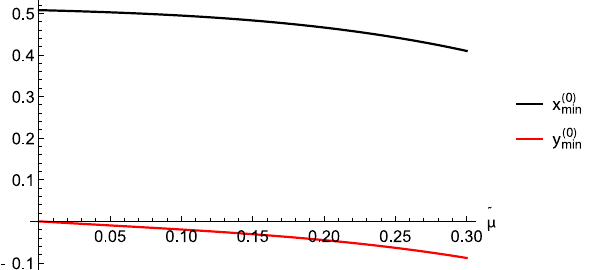
Fig. 5 The (weak) dependence of the position of the minimum in the basic sector on imaginary chemical potential. Beyond the ˜ μ shown in the figure, this minimum disappears and another minimum becomes deeper (as demonstrated in Fig.6). The parameters are g = 4, N f =